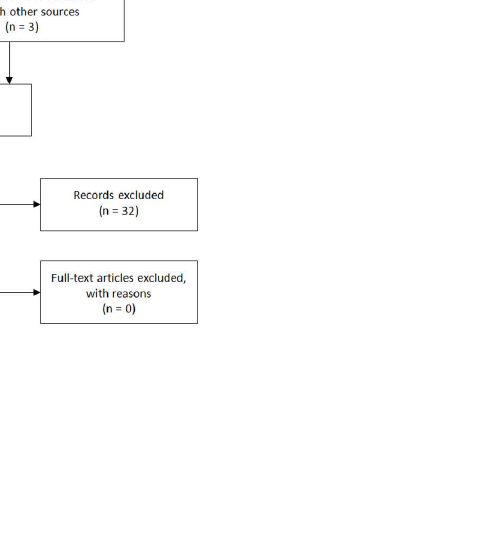
Fig 1. Flow Diagram based on PRISMA Statement